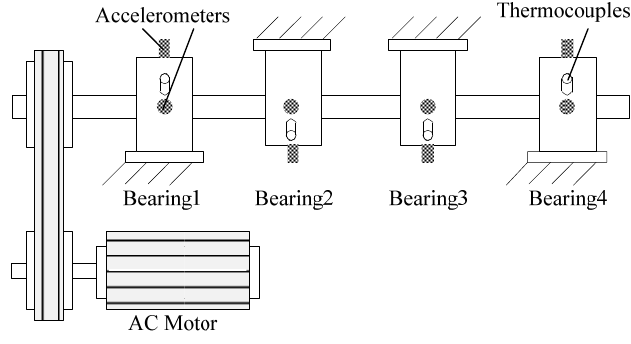
Figure 2. Bearing test rig.